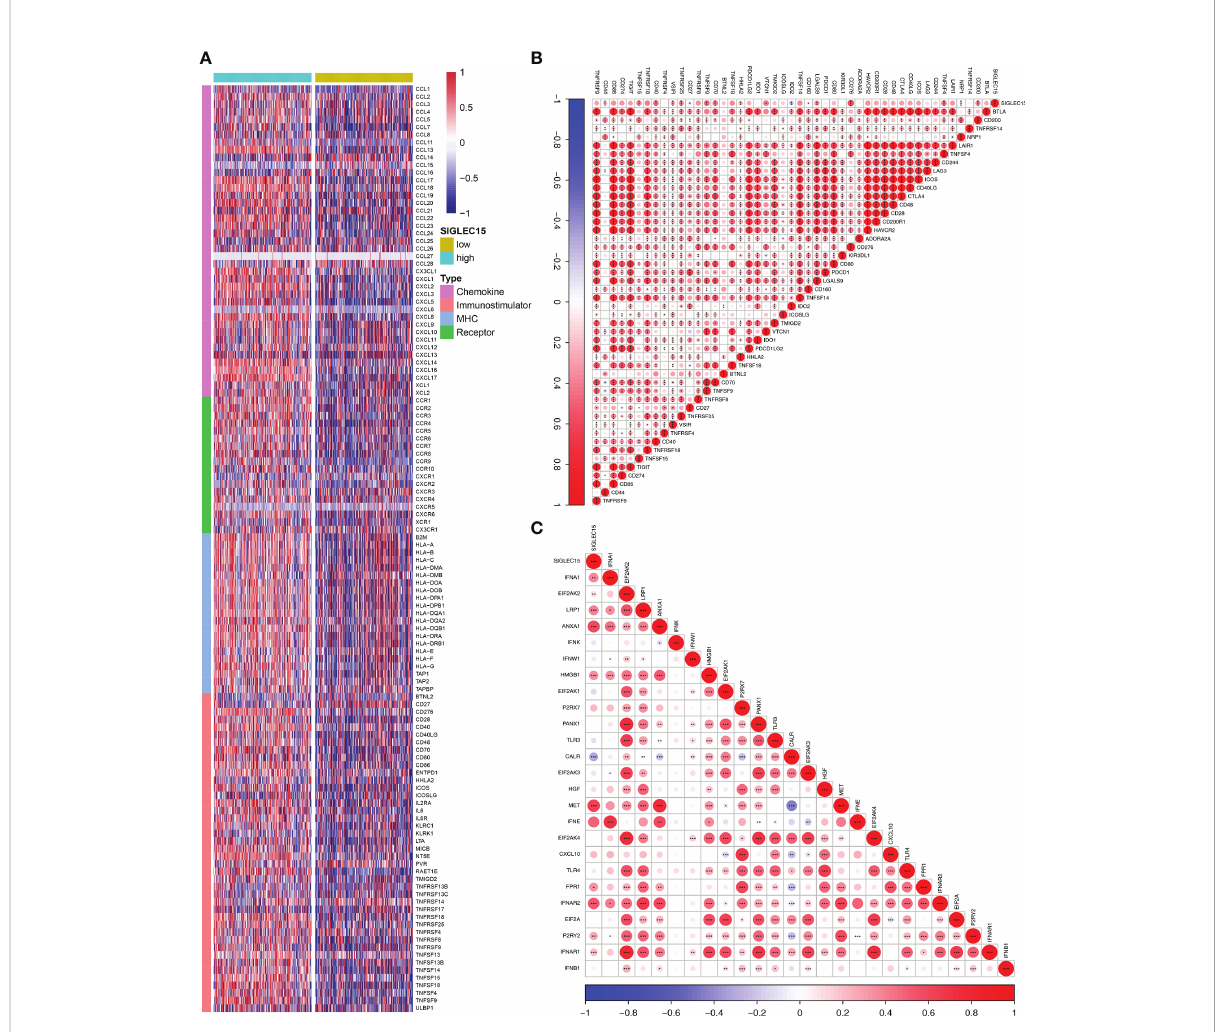
FIGURE 4 Immunological gene patterns related to SIGLEC15 . (A) Differential expression of 122 immunomodulators (chemokines, receptors, MHC, and immunostimulators) between the high and low SIGLEC15 groups. (B) ICP modulator relationship with SIGLEC15 . (C) ICD modulator relationship with SIGLEC15 . ns, *, **, and *** stand for p-value ≤ 0.05, p-value ≤ 0.01, pvalue ≤